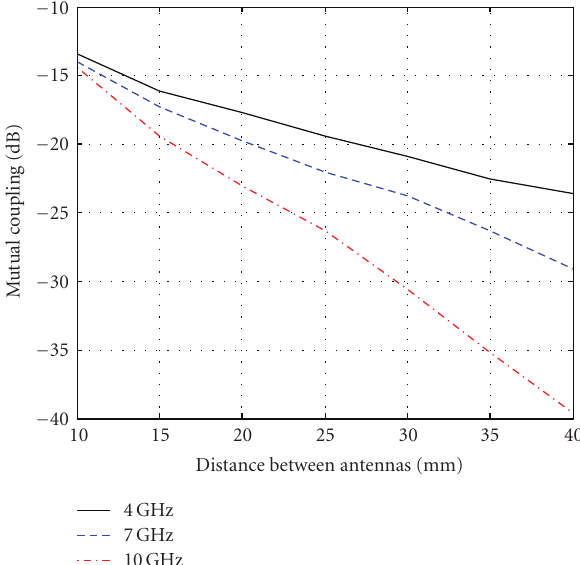
Figure 8: The simulated return loss of the antenna for di ff erent dis- tances from the human body.